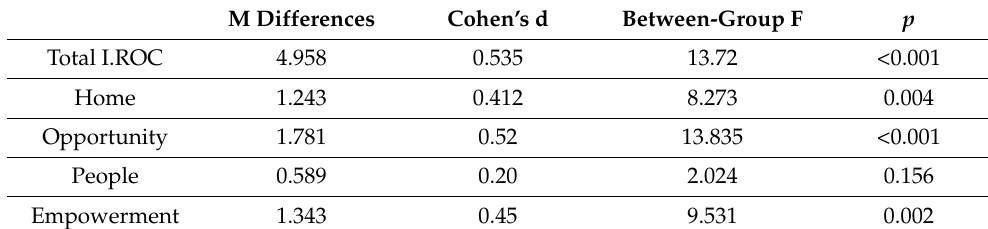
Table 3. Differences between MHDH group and non-MHDH